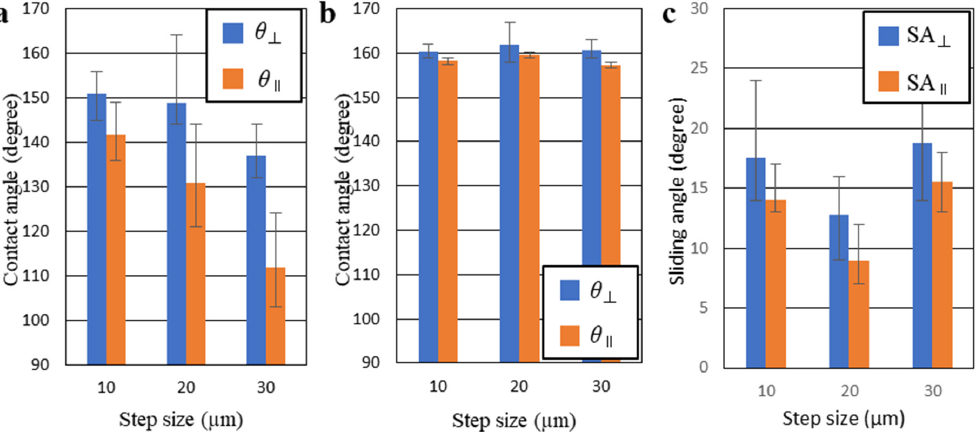
Figure 10. Summary of water droplet contact angles and sliding angles results: ( a ) the water droplet contact angles on the groove pattern surfaces without coating; ( b ) the water droplet contact angles; and ( c ) sliding angles on the groove pattern surfaces with coating.